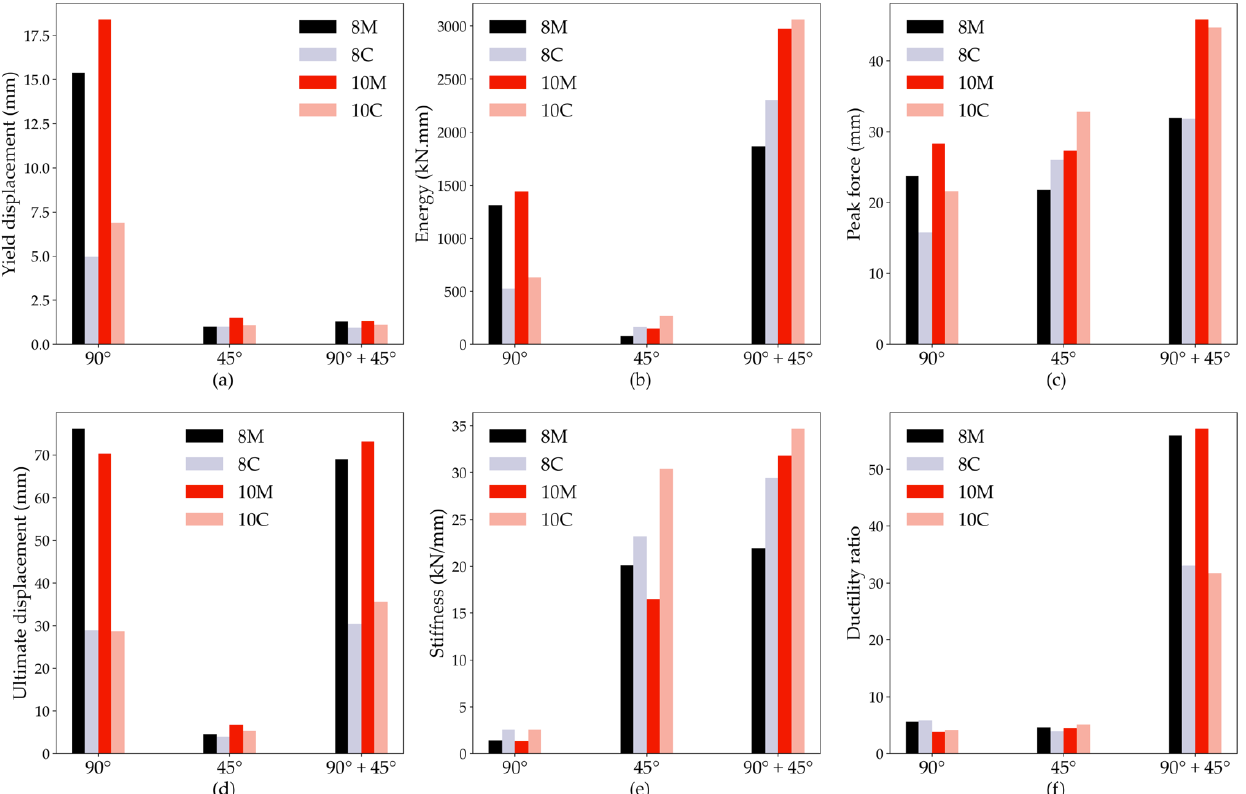
Figure 6. Comparison of average mechanical properties of STS connections: ( a ) yield displacement; ( b ) energy dissipation; ( c ) peak force; ( d ) ultimate displacement; ( e ) stiffness; ( f ) ductility ratio.